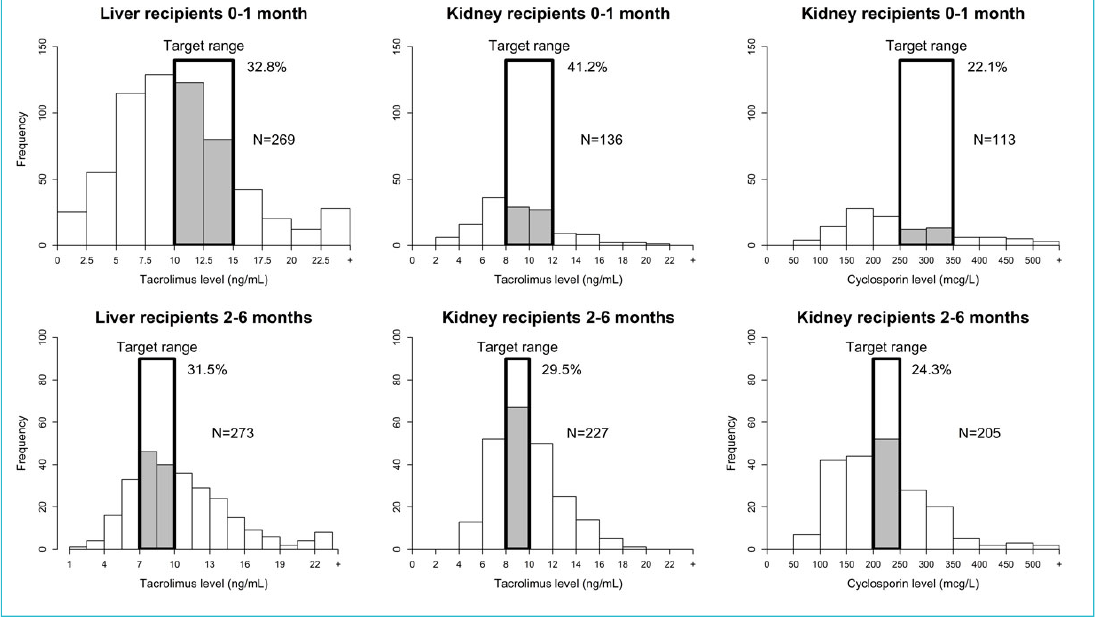
Figure 1: Number of sampled trough levels of each drug (tacrolimus and ciclosporin) during the first month and 2–6 months after liver (LT) and kidney (KT) transplantation and percentage of sampled levels in the target range.